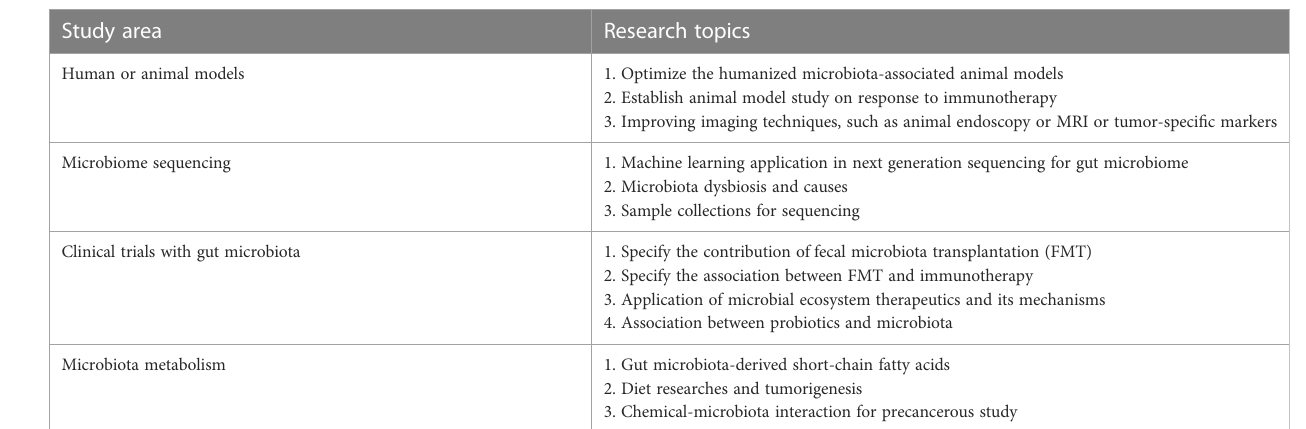
TABLE 1 Gut microbiome research for future